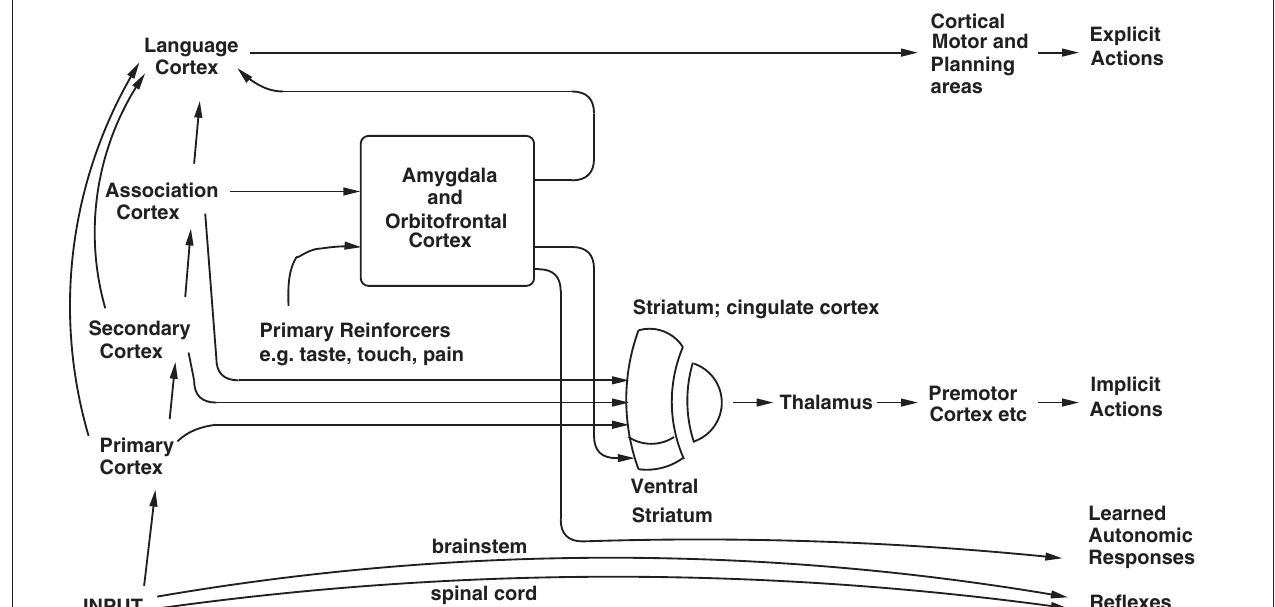
cortex” which outputs representations of objects to the amygdala and orbitofrontal cortex is the inferior temporal visual cortex. One route for the outputs from these evaluative brain structures is via projections directly to structures such as the basal ganglia (including the striatum and ventral striatum) to enable implicit, direct behavioral responses based on the reward or punishment-related evaluation of the stimuli to be made. The second route is via the language systems of the brain, which allow explicit decisions involving multi-step syntactic planning to be implemented. [After Rolls